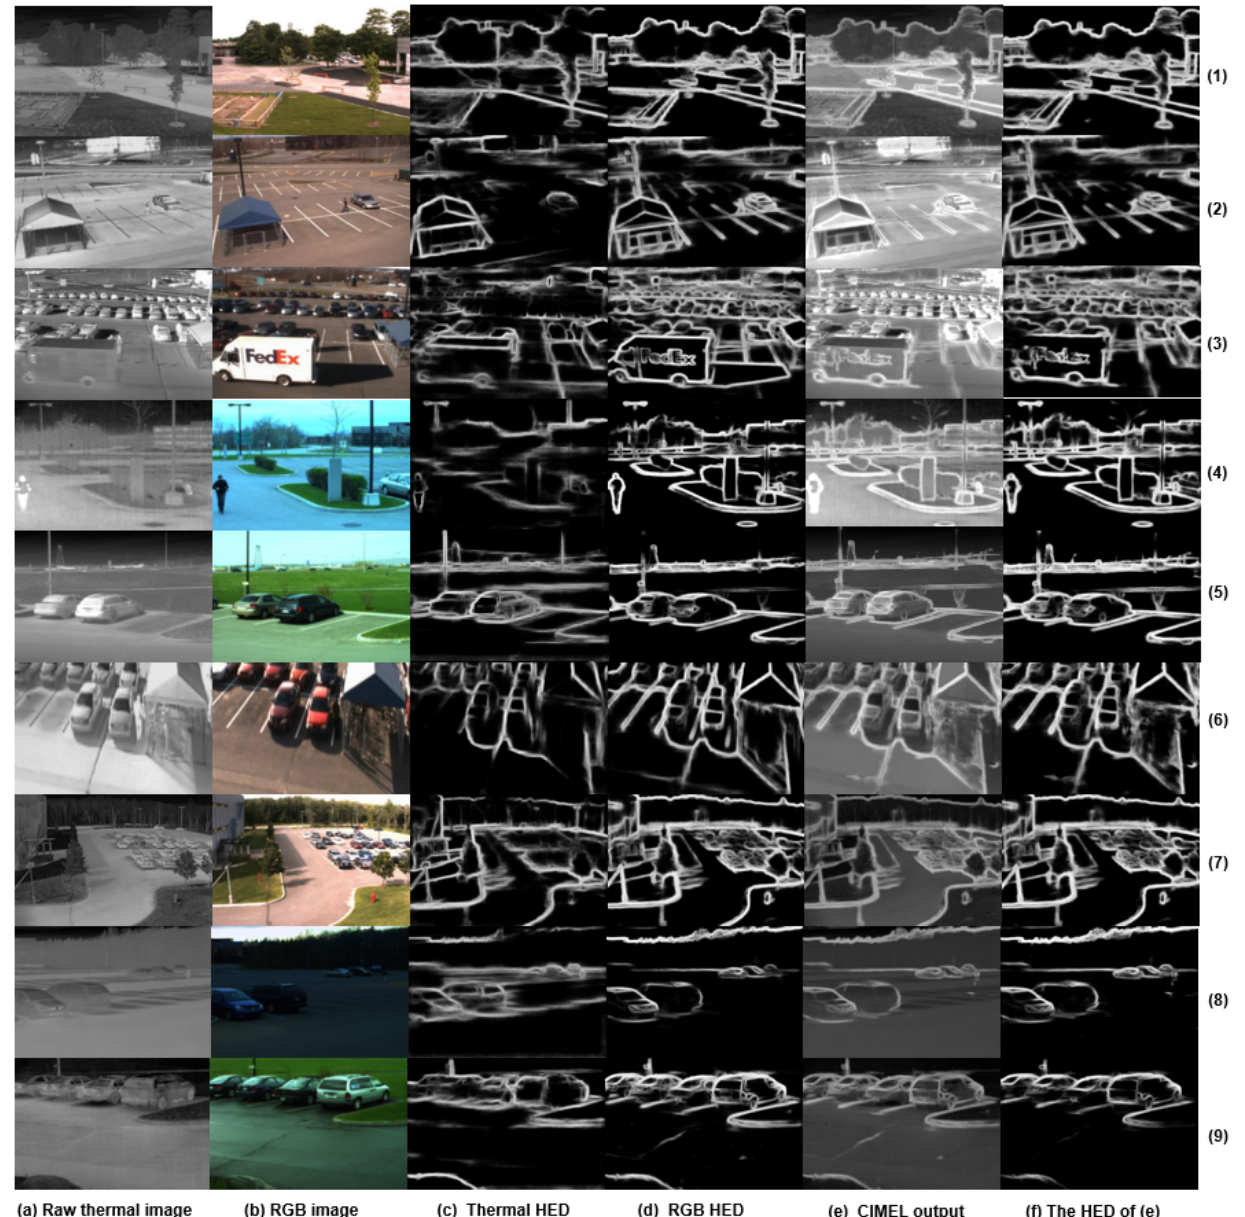
Figure 5. Results of 9 scenes using the proposed CIMEL framework where HED is used for edge